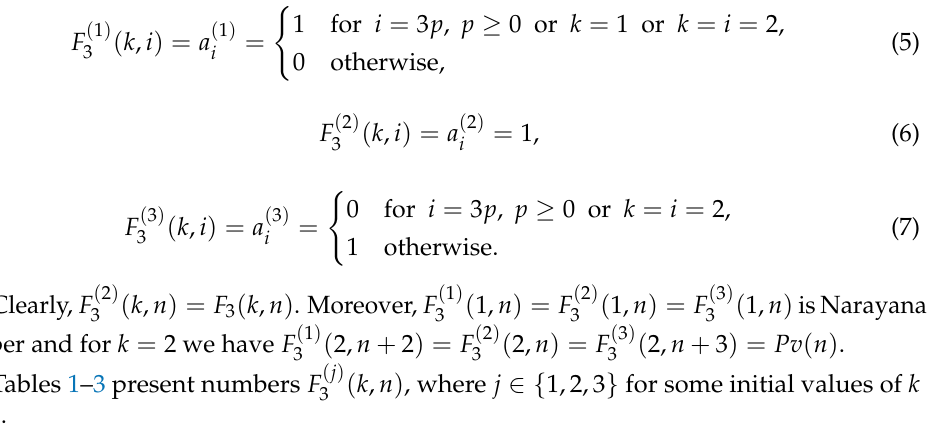
( 1 ) ( k , n ) for k ∈ { 1,2, . . . ,6 } . 3